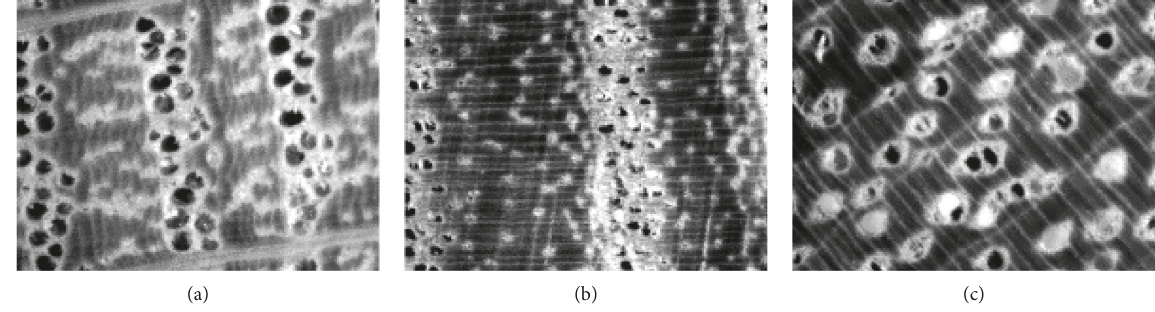
Figure 1: Microscopic hyperspectral images of cross sections of different hardwood species. (a) Quercus rubra . (b) Fraxinus americana . (c) Intsia bijuga .